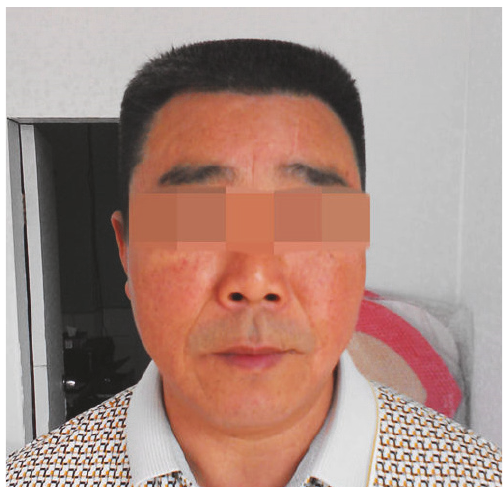
Figure 3: Hair grown completely (September,